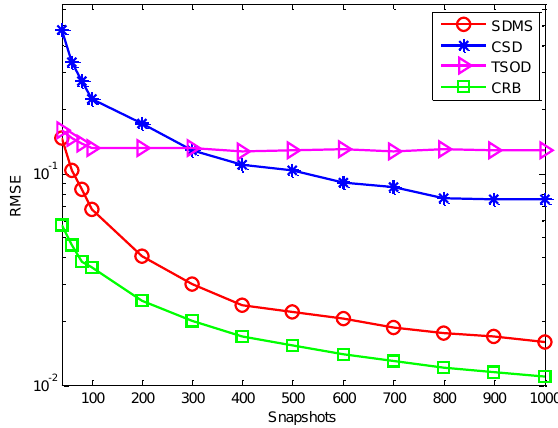
Figure 6. Performance versus the number of snapshots in the white noise condition.